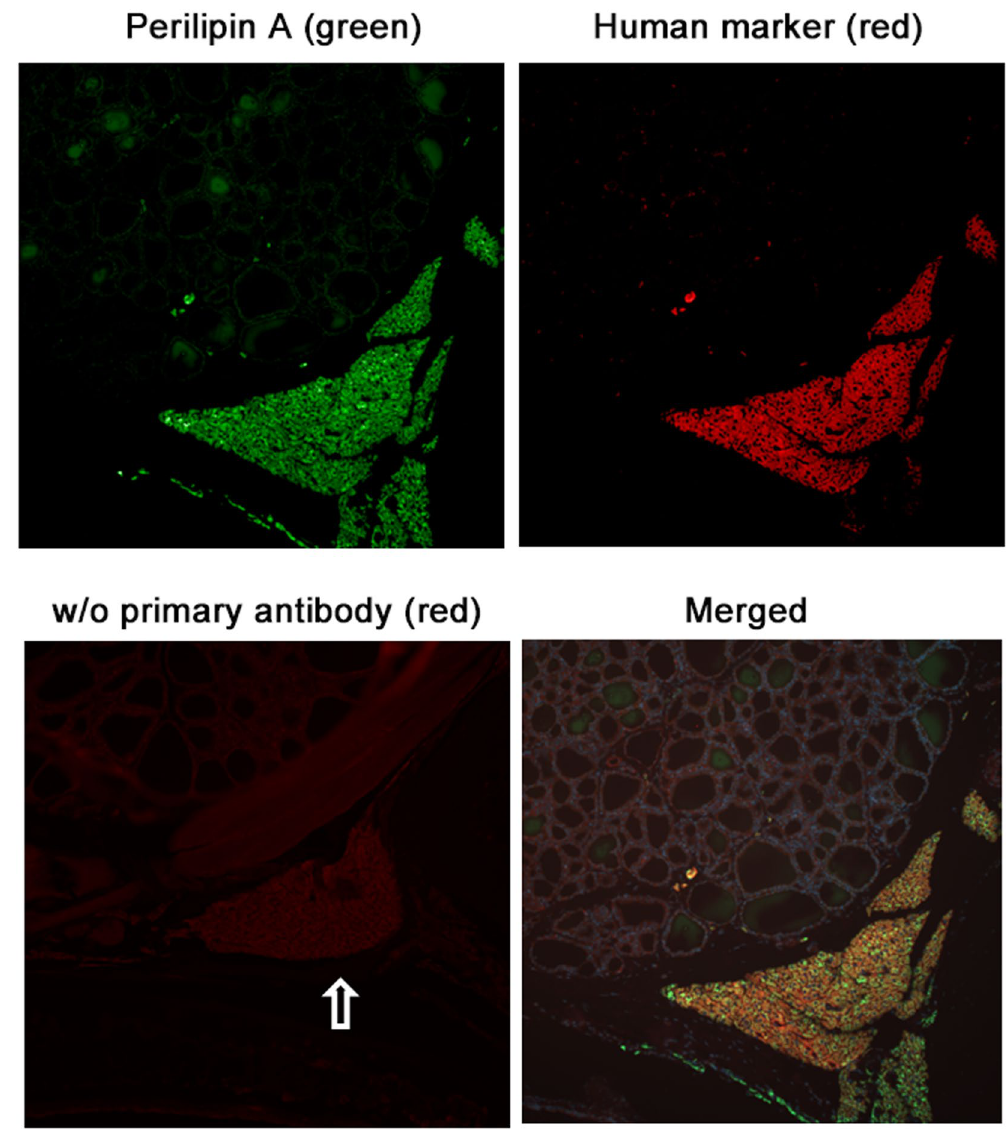
Figure 5. Post-transplant expression of perilipin A in transplanted parathyroid parenchymal tissues from secondary hyperparathyroidism patients. The transplants shown in Fig. 4 were examined for perilipin A expression. Bound anti-perilipin A antibody was fluorescently visualized with Alexa 488 (green) and bound anti-human cytoplasm antibody with Alexa 594 (red). These views were merged and are shown under Merged . As a negative staining control, the section was stained without the primary antibody and viewed with red fluorescence. The empty arrow indicates human